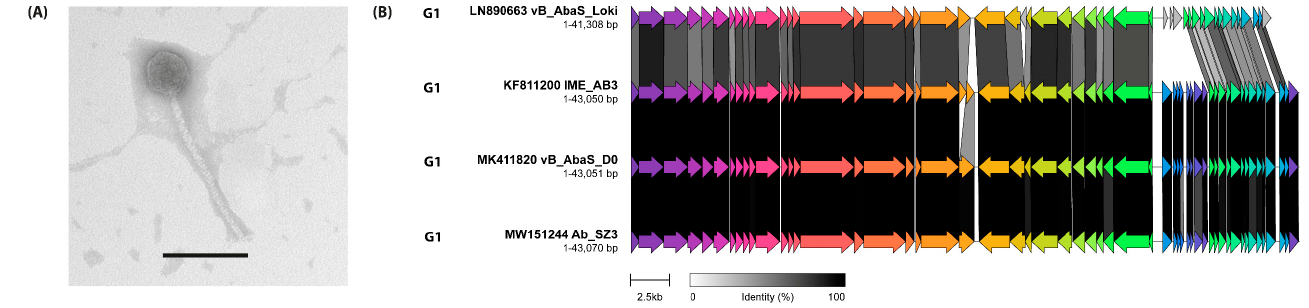
Figure 10. ( A ) Transmission electron micrograph of Acinetobacter phage Loki. The scale bar represents 100 nm. ( B ) Com- parative genome alignment of phages comprising sub-cluster G1. Phage genomes are presented alongside their designated sub-cluster, accession number, name and genome length. Coding sequences are represented by arrows, coloured to reflect homologous groups identified by Clinker, and are linked by grey bars shaded to represent the percentage amino acid identity, as indicated in the legend.